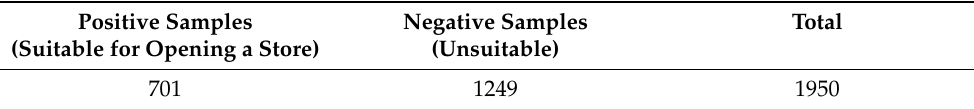
Table 7. Statistic of store site recommendation